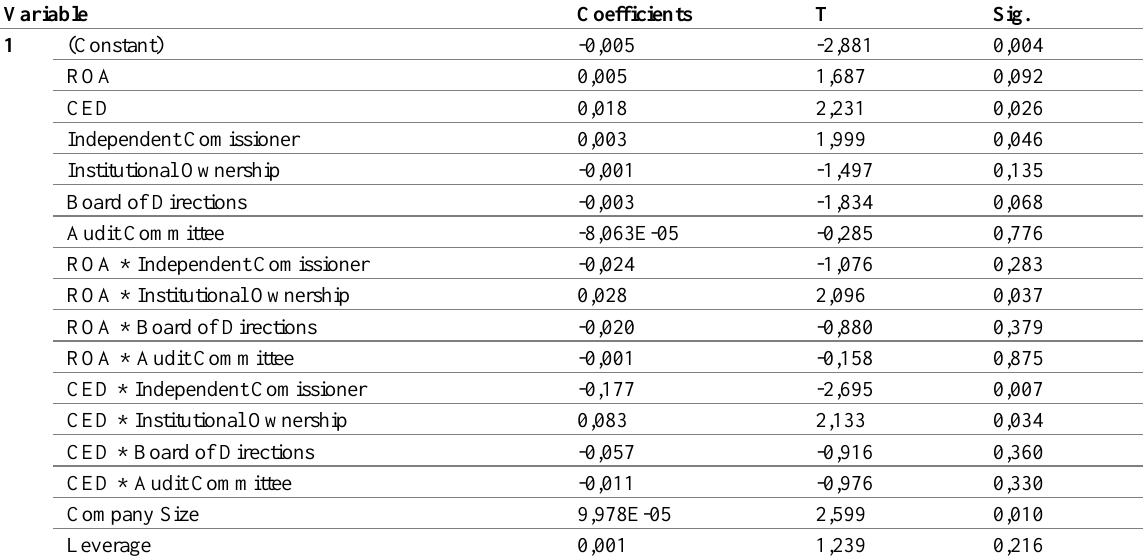
Table 5: Results of moderation regression